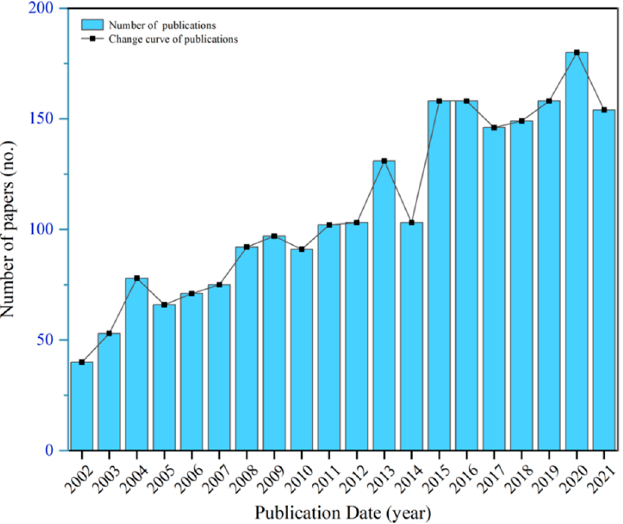
Figure 2. The number of domestic and international published literature on tree decay and stem cavitation from 2002 to 2021.